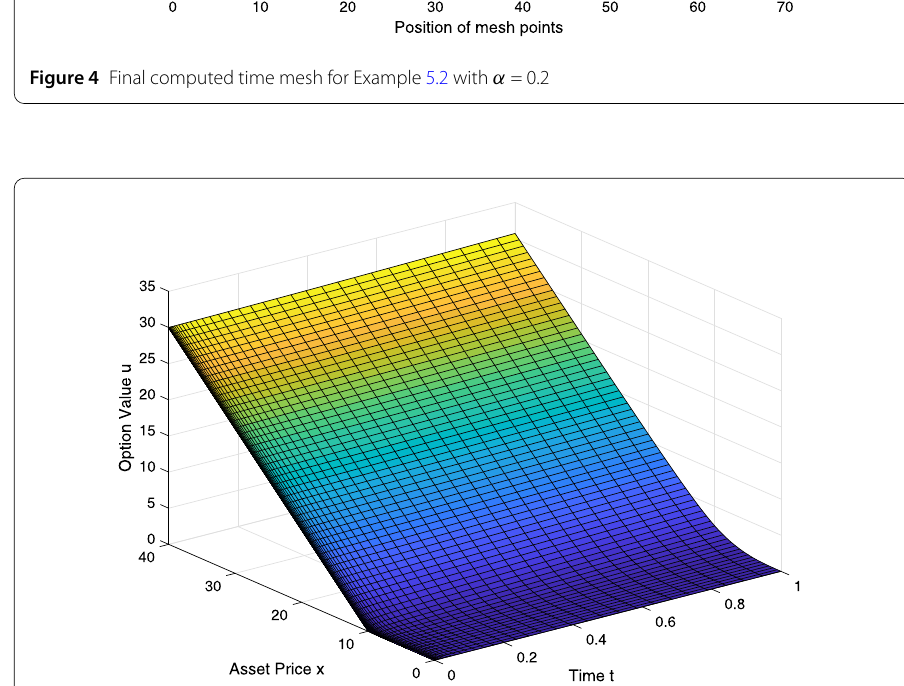
Figure 5 Computed option value U for Example 5.2 with α =